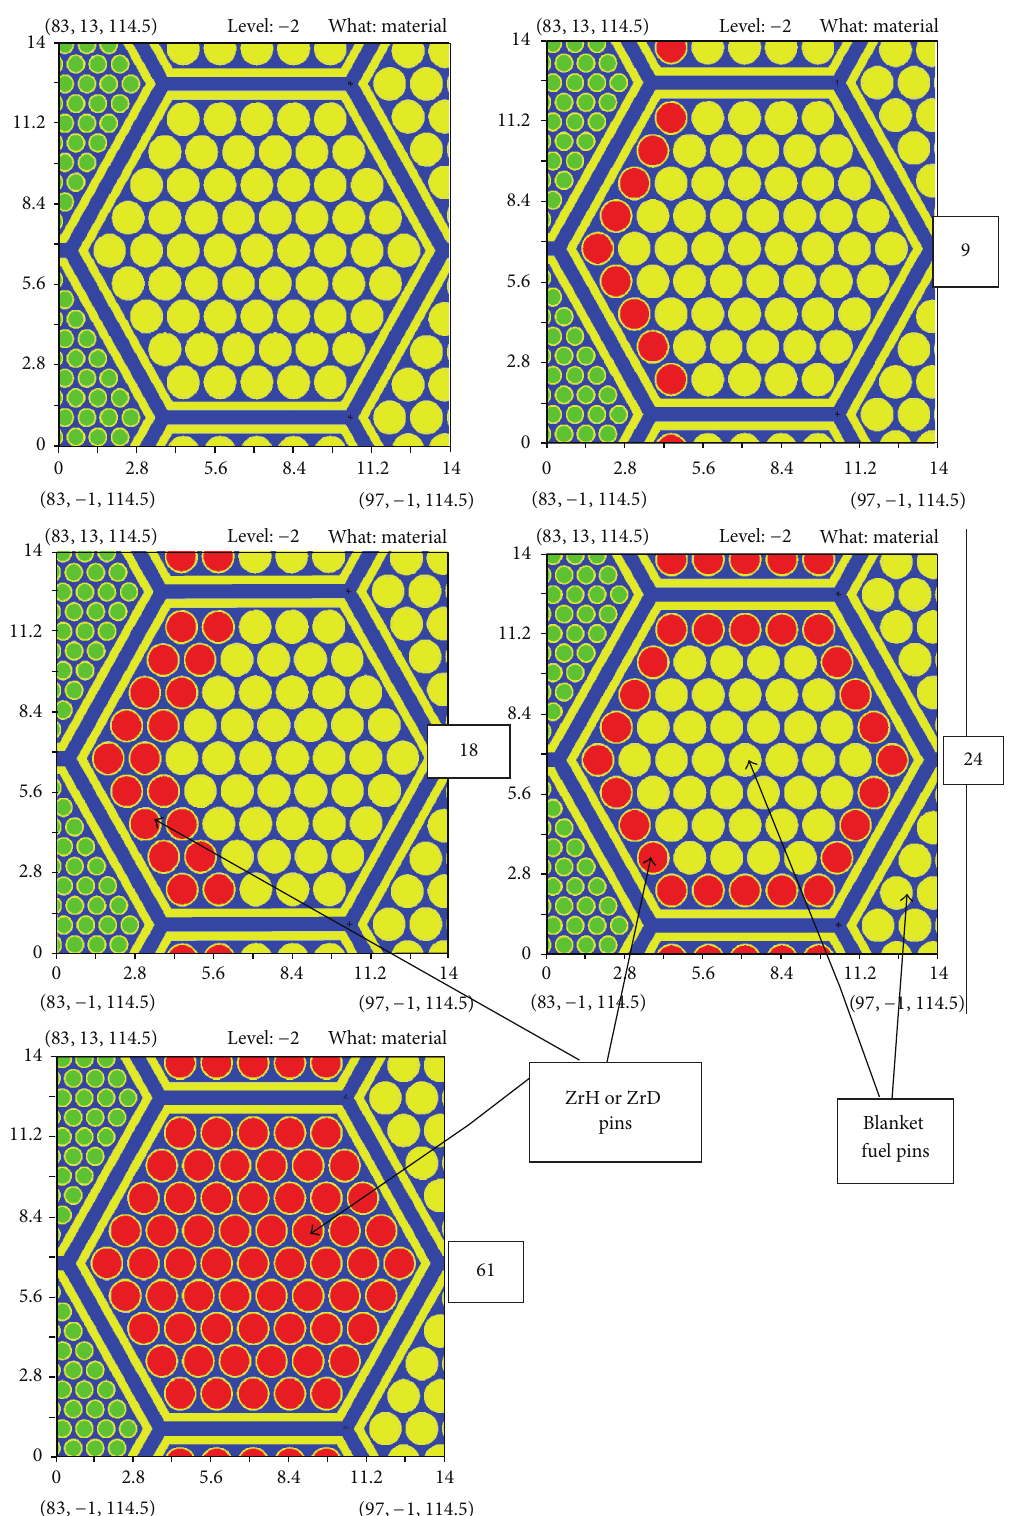
Figure 1: Pin arrangements in moderator